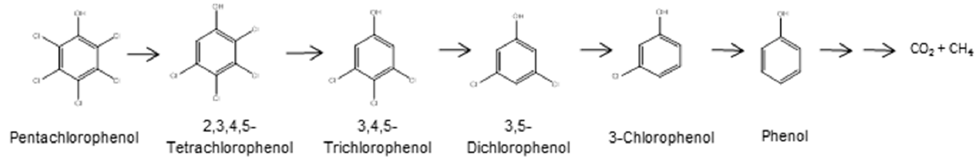
Figure 3. Anaerobic dehalogenation of PCP